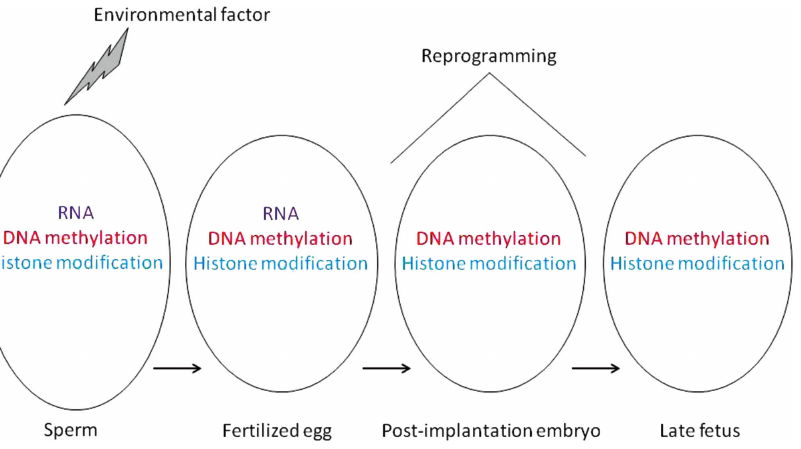
Figure 3: Epigenetic information propagation. Accumulated evidence of epigenetic information propagation across generations is depicted. Note survival of marks across both zygotic and early embryonic